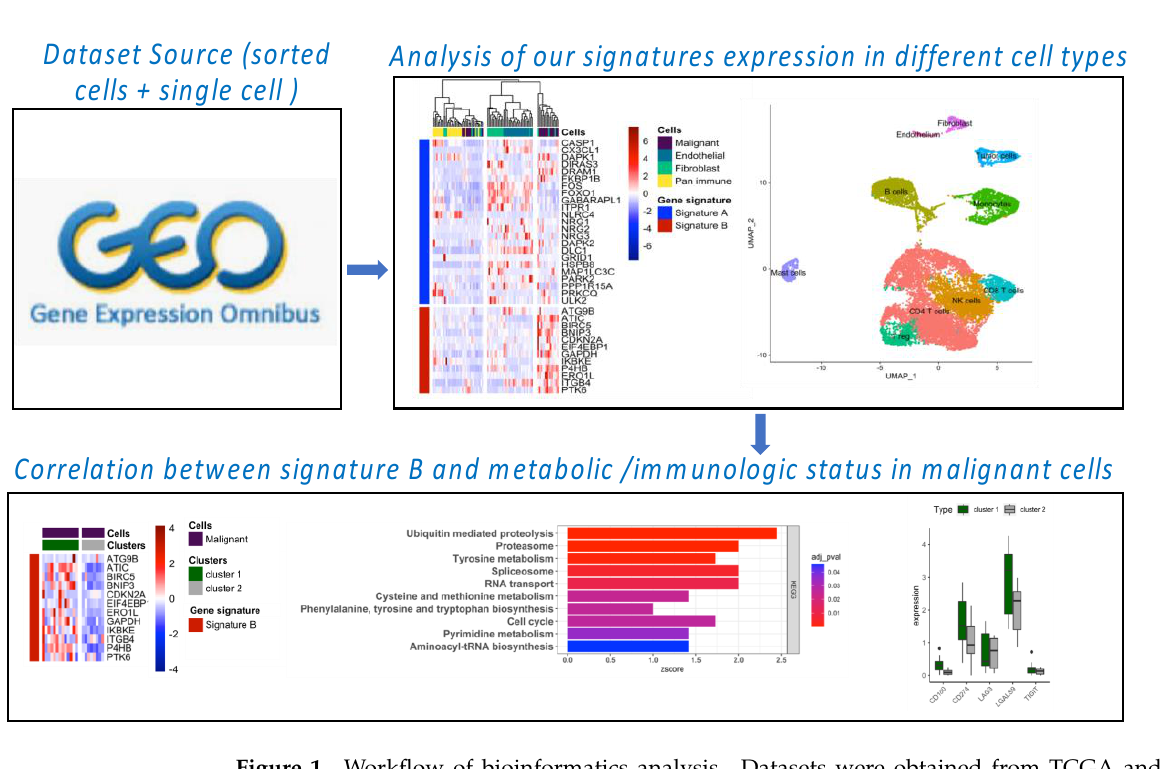
Figure 1. Workflow of bioinformatics analysis. Datasets were obtained from TCGA and GSO data- bases. Differential expression analysis was performed for 232 autophagy genes (human autophagy database) between tumor and adjacent tissue, and clusters of patients were examined in terms of survival and other clinical features. Correlations between autophagy clustering and metabolism or immunologic pathways were studied. The autophagy signature was studied in flow-sorted malig- nant, endothelial, immune and fibroblast cells from freshly resected primary human NSCLC and in single-cell sequencing data, showing a predominant expression of signature B in the malignant